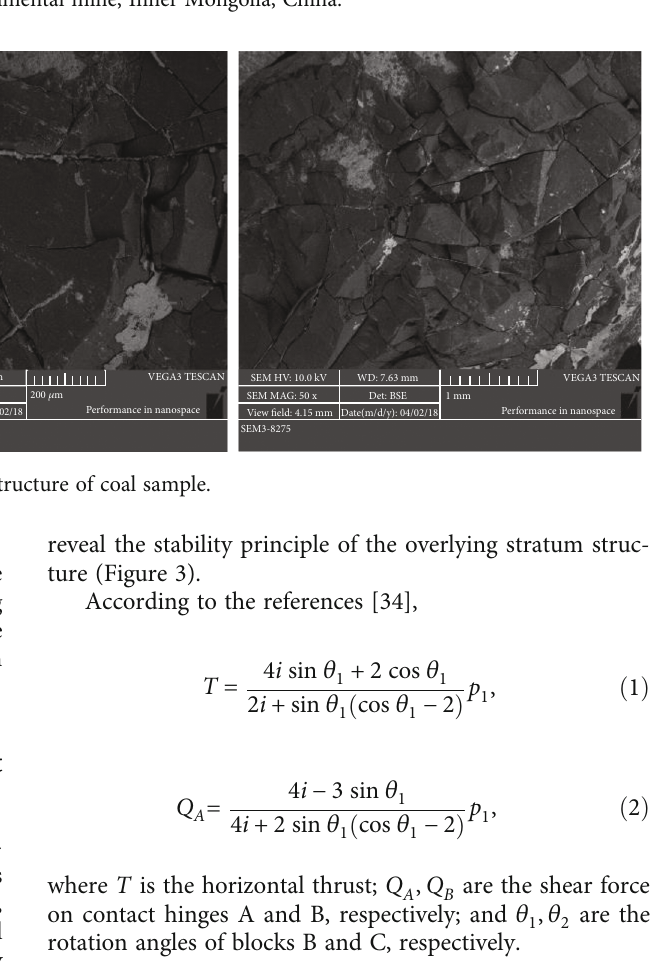
Figure 1: Location of the experimental mine, Inner Mongolia, China.